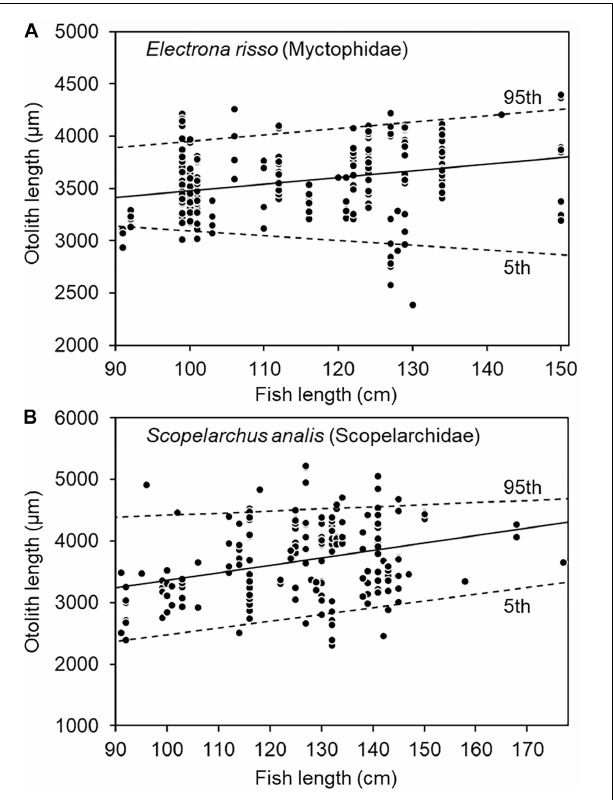
FIGURE 8 | Relationship between fish length of bigeye tuna ( Thunnus obesus ) and prey otolith length of (A) Electrona risso (Myctophidae) and (B) Scopelarchus analis (Scopelarchidae). The solid lines indicate the least-squares regression and dotted lines the 95th and 5th quantile